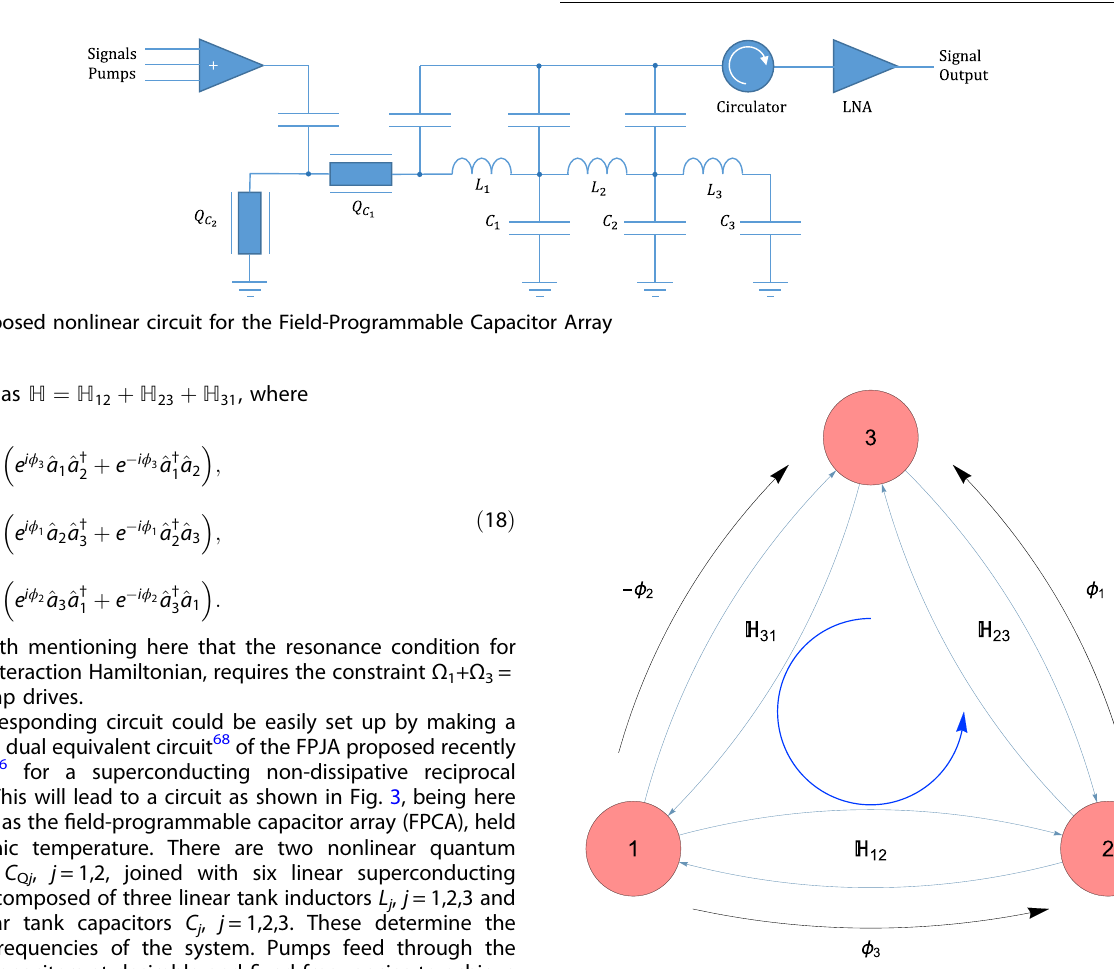
Fig. 4 The mode coupling scheme in an ideal circulator. The signal can take two pathways for conversion from, say, mode 1 to mode 3. The phase difference between the two paths, Δ ϕ , can be controlled provides the condition for interference and by setting Δ ϕ ¼ ± π 2 between the paths. Hence only one pathway is preferred (say, anti- clockwise, blue curve ) and not the opposite (clockwise) for mode conversion. In this scheme, any one of the three modes can be taken as the input while any of the other two may play the role of